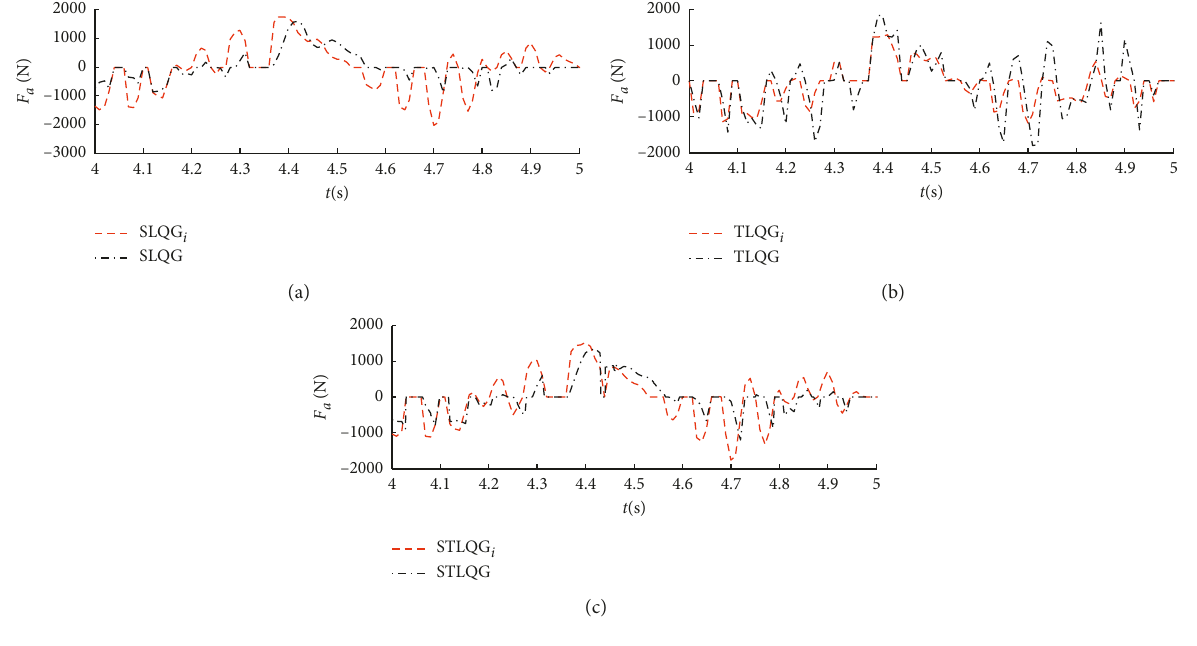
Figure 7: F a - t curves under 25ms time delay (partial enlargement).